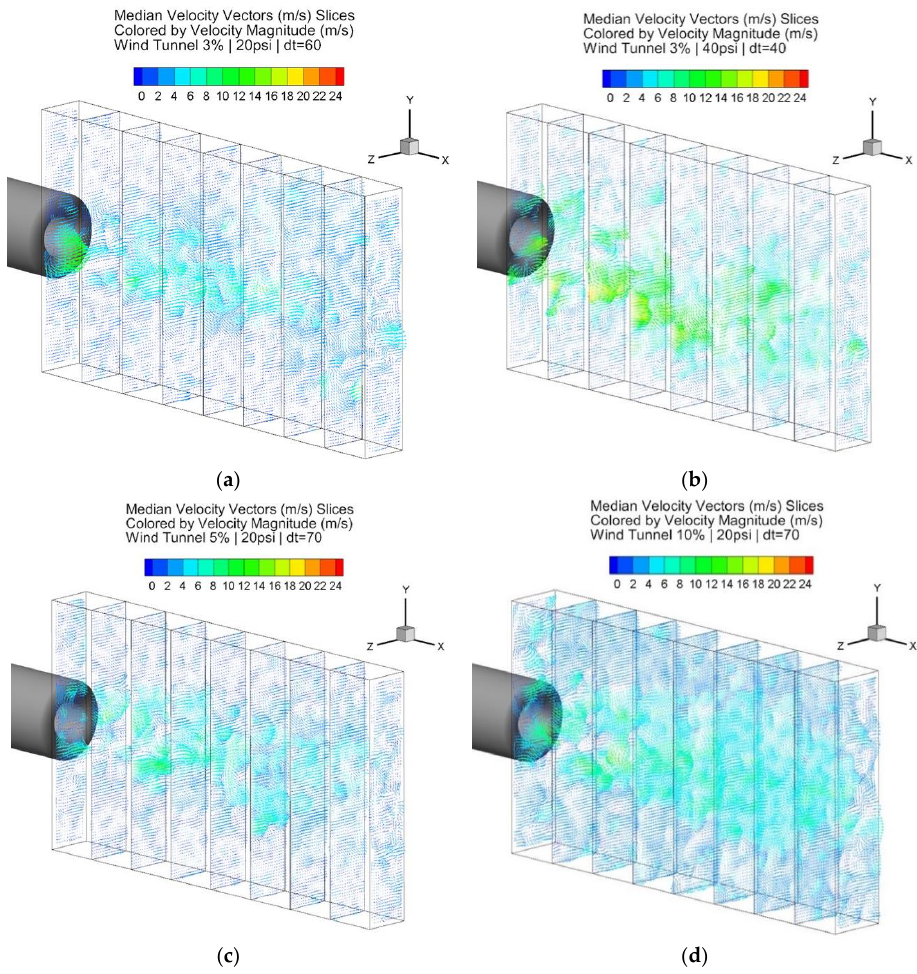
Figure 12. Instantaneous velocity vector slices normal to streamwise direction compared at 3% wind tunnel setting and vortex tube pressures of 20 psi ( a ) and 40 psi ( b ), and comparing at a vortex pressure of 20 psi the freestreams from wind tunnel settings of 5% ( c ) and 10% ( d ).